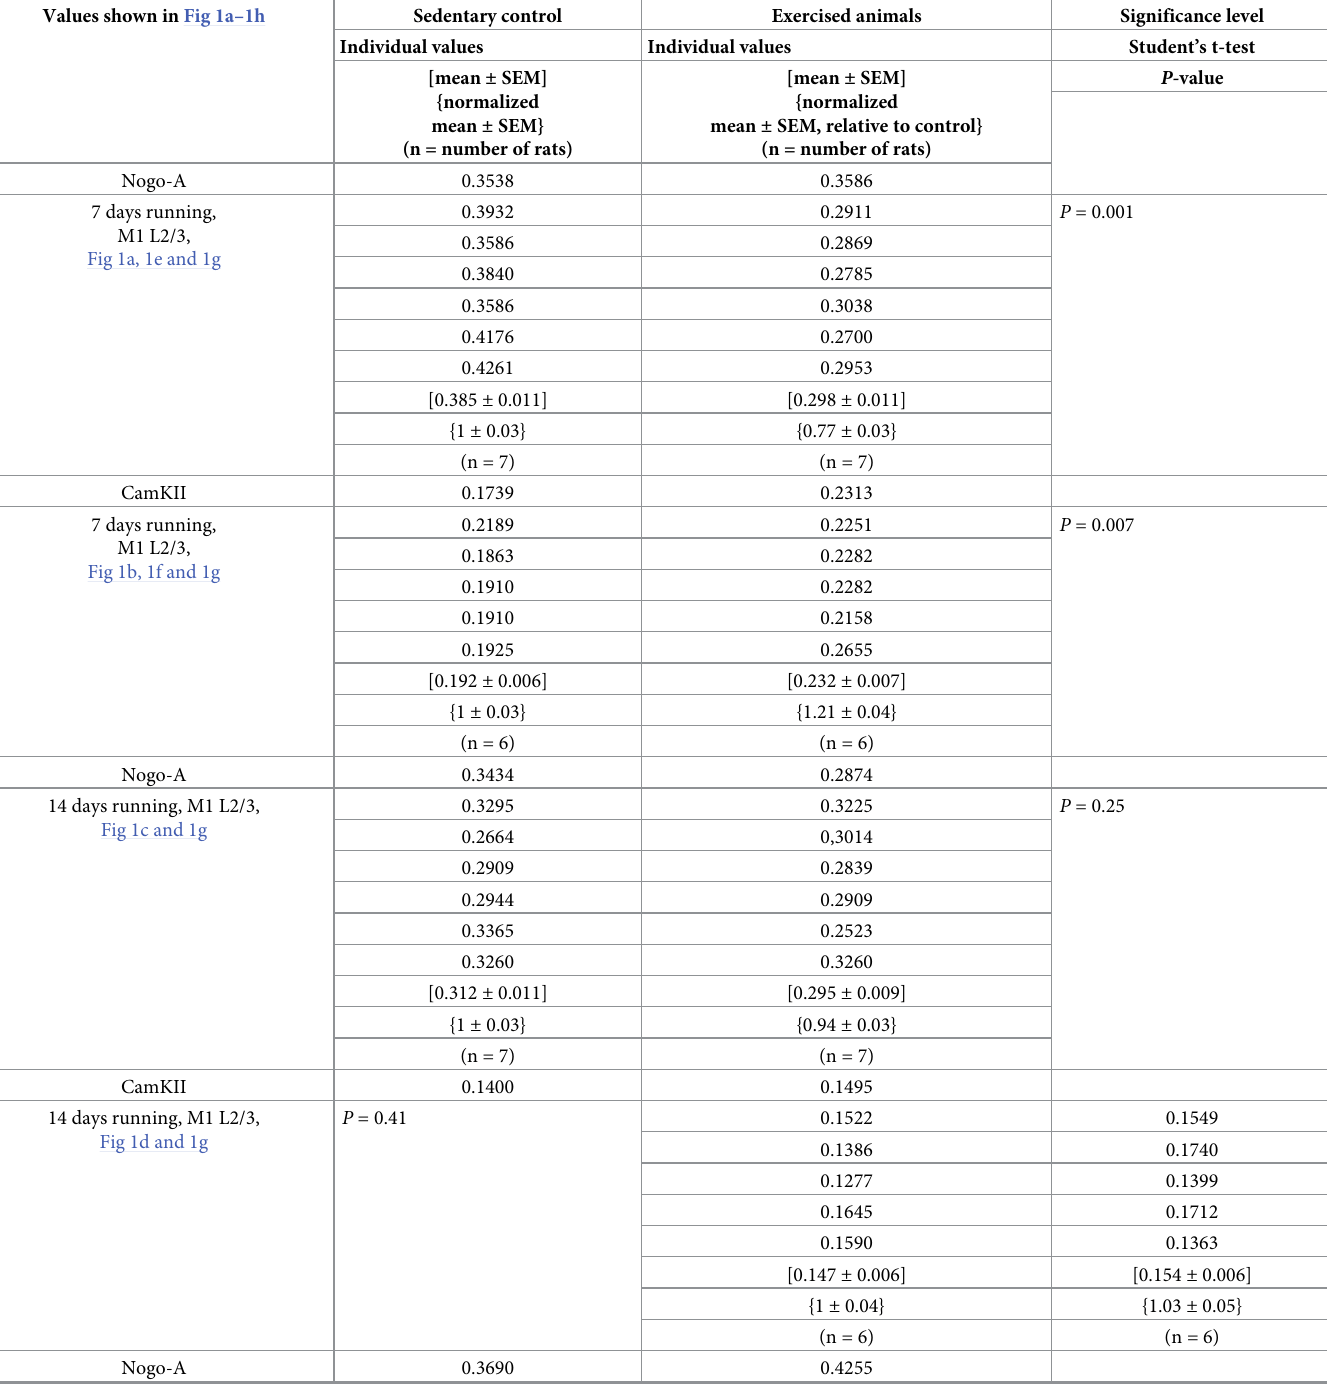
Table 1. Relative Optical Density [ROD] from Nogo-A and CaMKII protein levels in the motor cortex after 7 respectively 14 days of running wheel exercise. Values shown in Fig 1a–1h